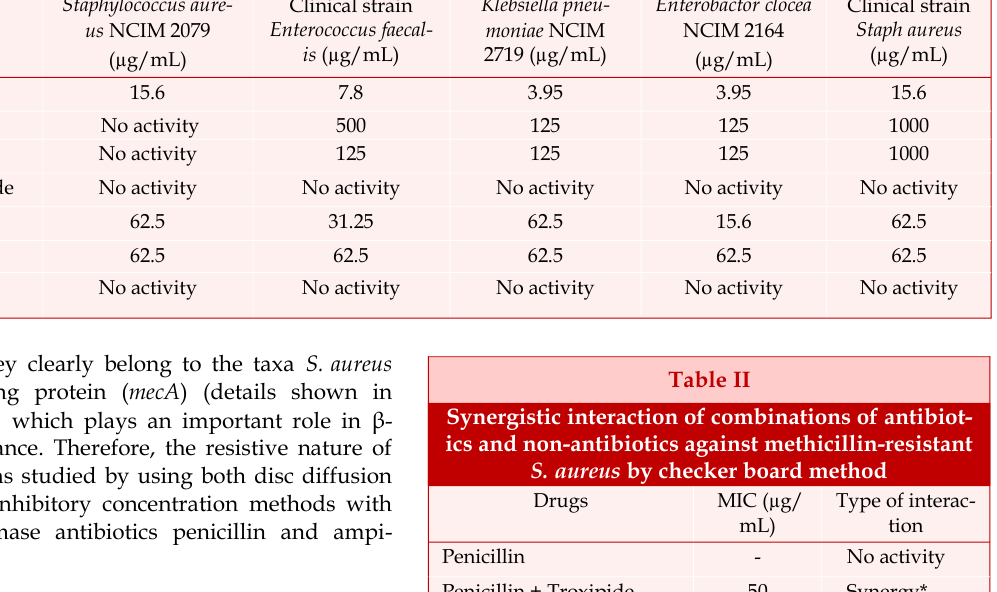
Minimum inhibitory concentrations (MICs) of the selected drugs and antibiotics by broth dilution method Staphylococcus aure-